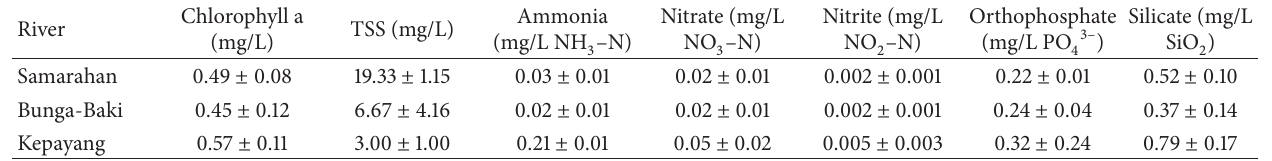
Table 4: Selected water quality parameters measured ex situ